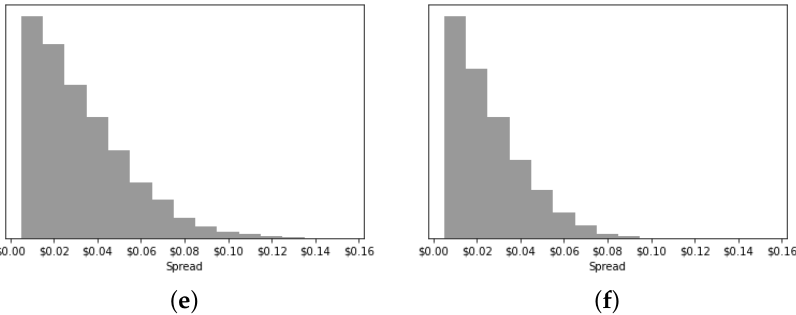
Figure 10. Spread sample distribution. ( a ) CDA. ( b ) FBA (0.5). ( c ) FBA (1.0). ( d ) HVCDA. ( e ) FBA (1.5). ( f ) FBA (2.0).